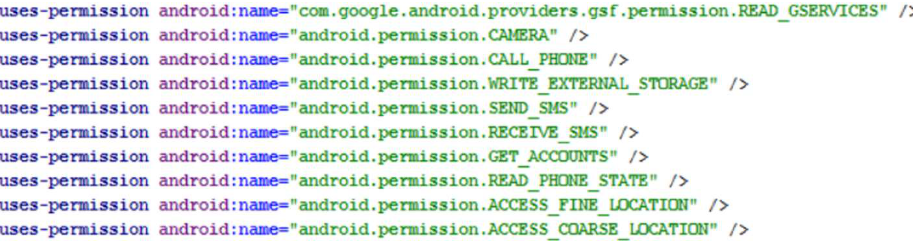
Figure 2. Malware Types.